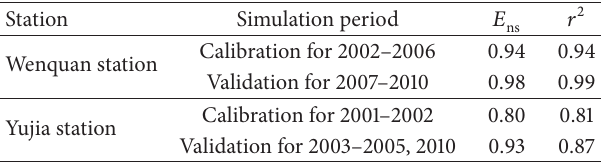
Table 4: Simulation results of runoff in the two basins. Station Simulation period 𝐸